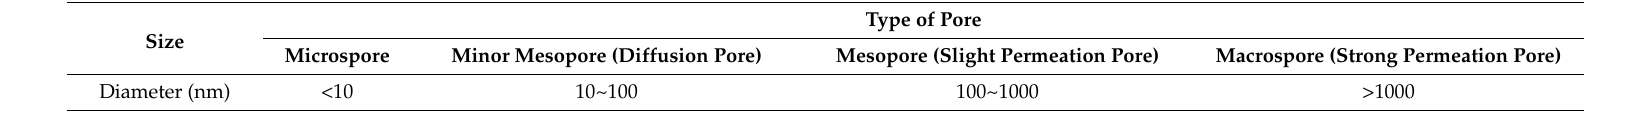
Table 3. The common method of pore classification of coal in China.